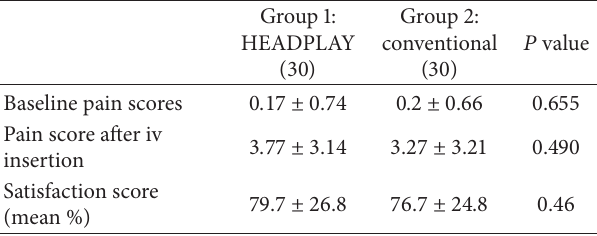
Table 3: Pain and satisfaction scores.